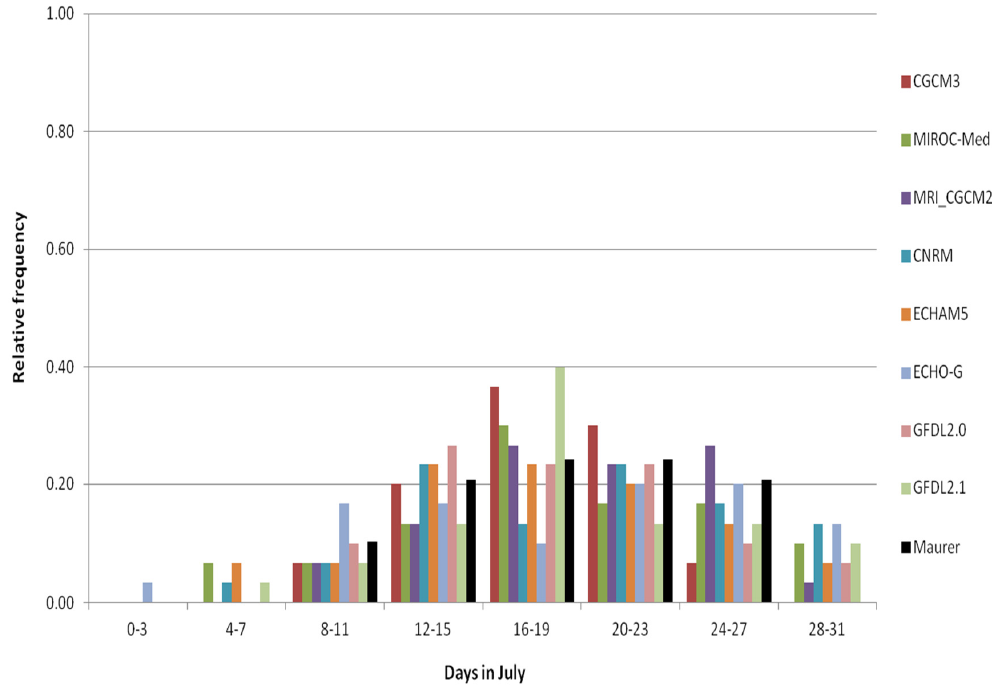
Figure 7. Histogram of HD30 in July for a grid cell that overlays the Washington DC area, based on the bias-corrected individual 8 CMIP3 GCMs re-gridded to 2° × 2° resolution—BC GCM_2deg data, 1971–2000.